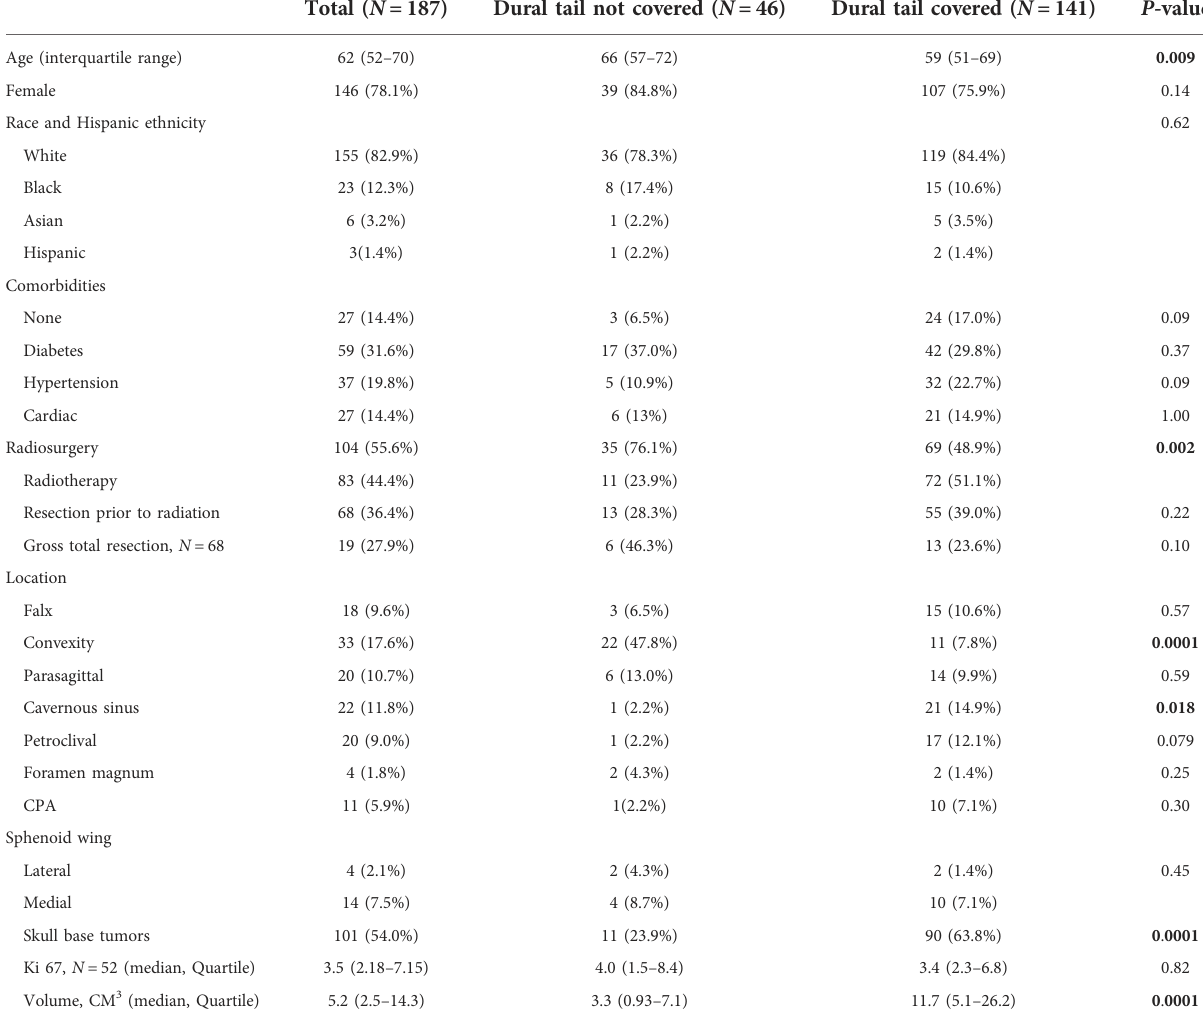
TABLE 1 Demographics of 177 patients with 187 radiation treated grade 1